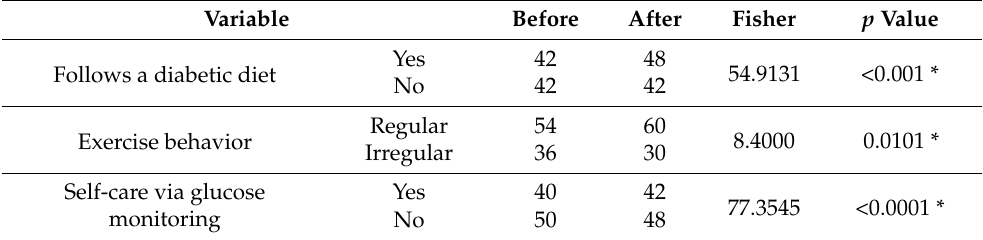
Table 5. Self-care actions before and after the health promotion